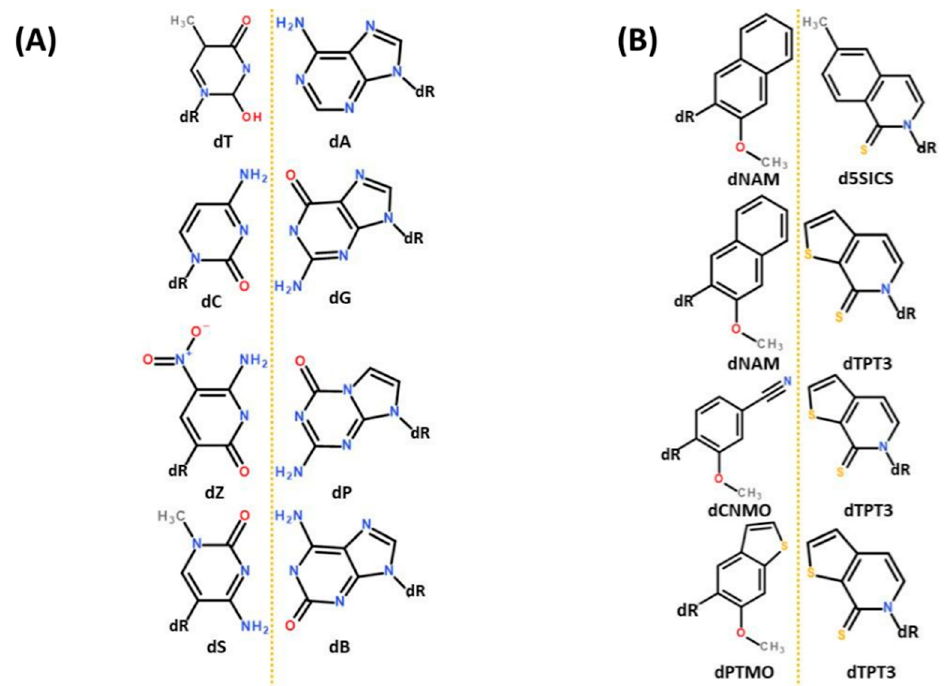
Figure 3. Two very different synthetic nucleotide alphabets developed to the point of in vivo functioning. ( A ) The Hachimoji alphabet [20] emulates Watson-Crick base pairing using the four atom types known to “natural” nucleotides (N, O, H and C). ( B ) Romesberg and colleagues’ genetic alphabet [21] achieves base pairing through hydrophobic and packing forces and uses sulfur, an atom type unknown to ‘natural’ genetics.